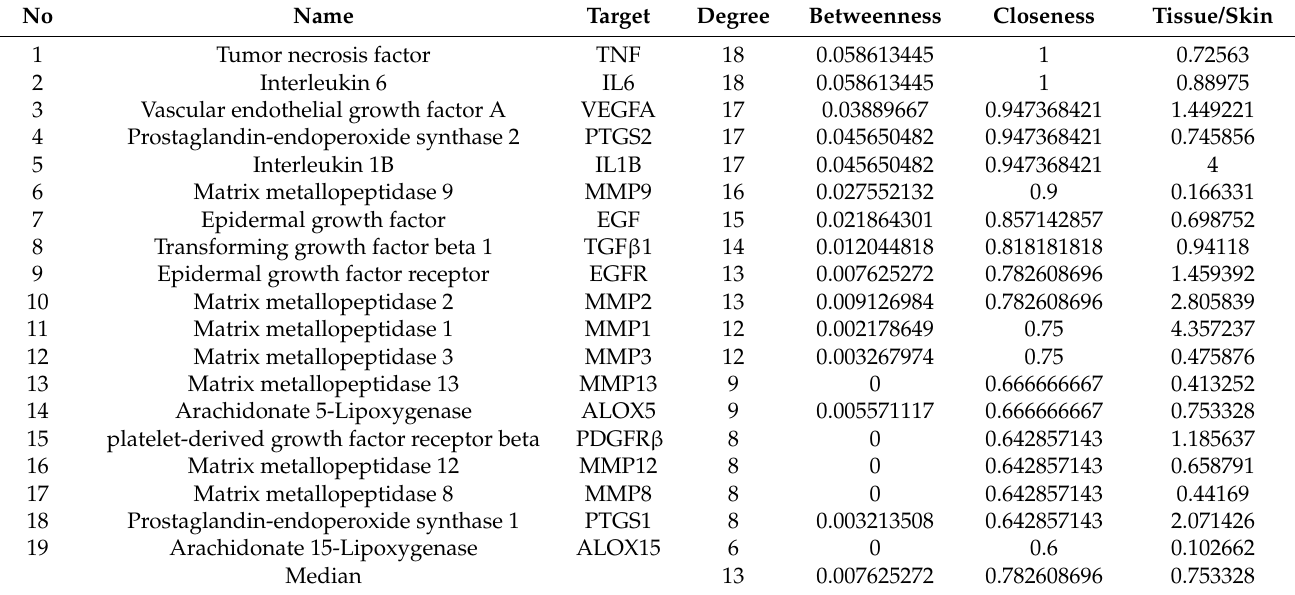
Table 2. Topological parameters of targets combined with skin tissue expression